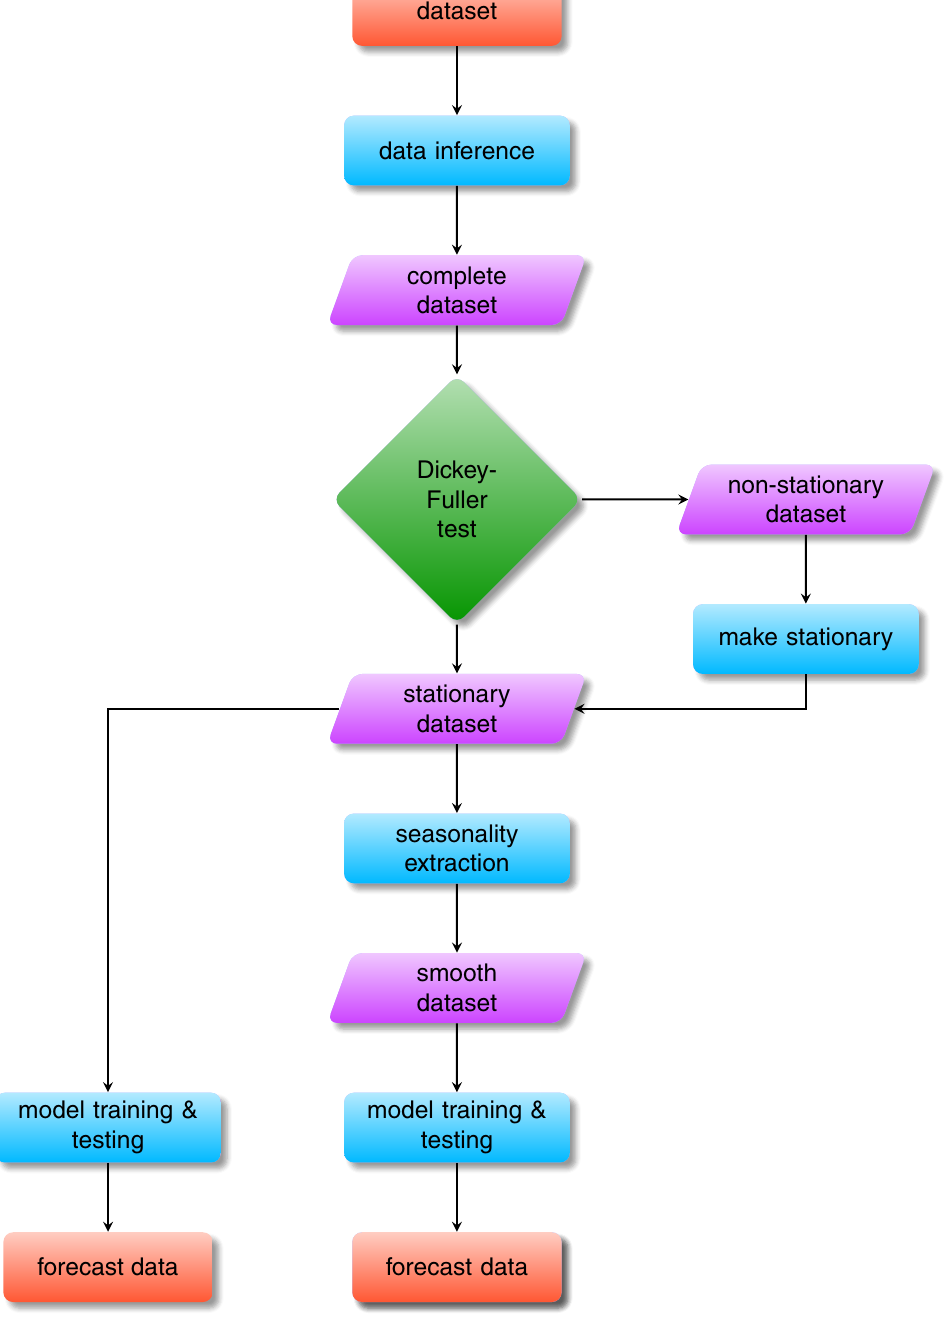
Figure 1. Data processing flowchart and algorithm